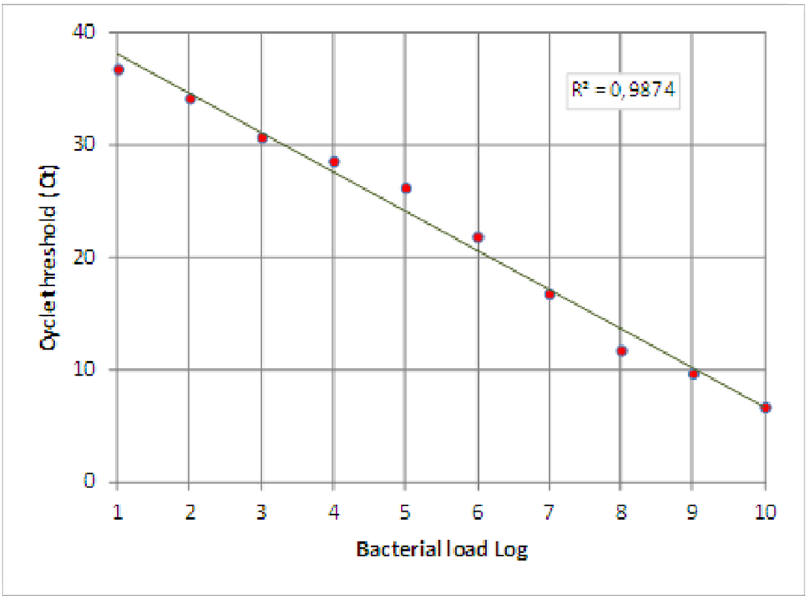
Fig 1. Standard curve of H. pylori q-PCR